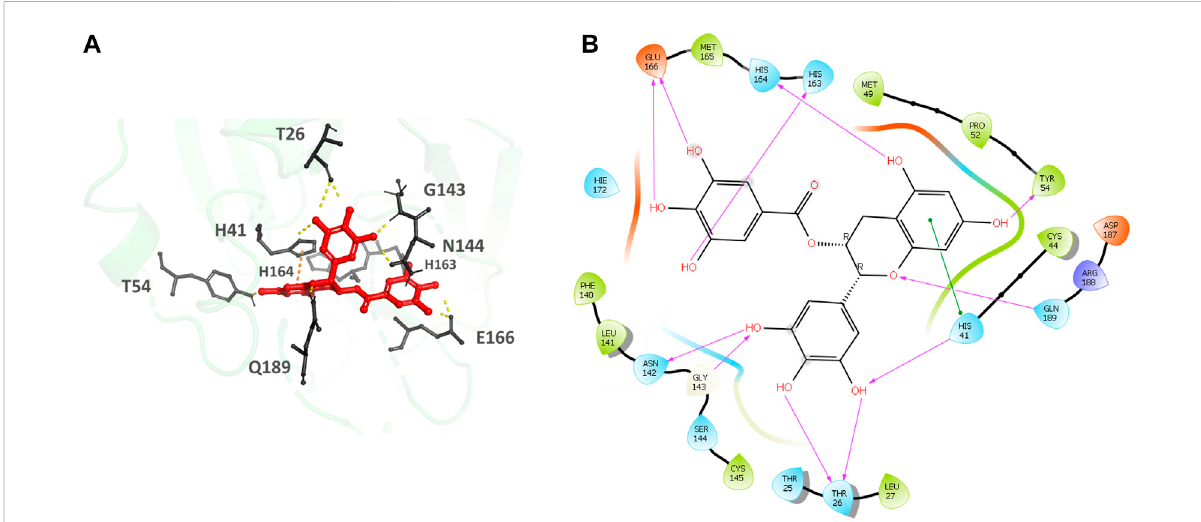
FIGURE 5 (A) Epigallocatechin gallate bound to the monomer of the SARS-CoV-2 MPro at the POOL predicted secondary site. The protein backbone is shown in green cartoon representation, ligand in red with the residues in gray. The hydrogen bonds are shown as yellow dashes and π - π stacking interactions as orange dashes. (B) Ligand interaction diagram of Epigallocatechin gallate at the secondary site. The hydrogen bonds are shown as pink arrows and π - π stacking interactions are shown as green lines.